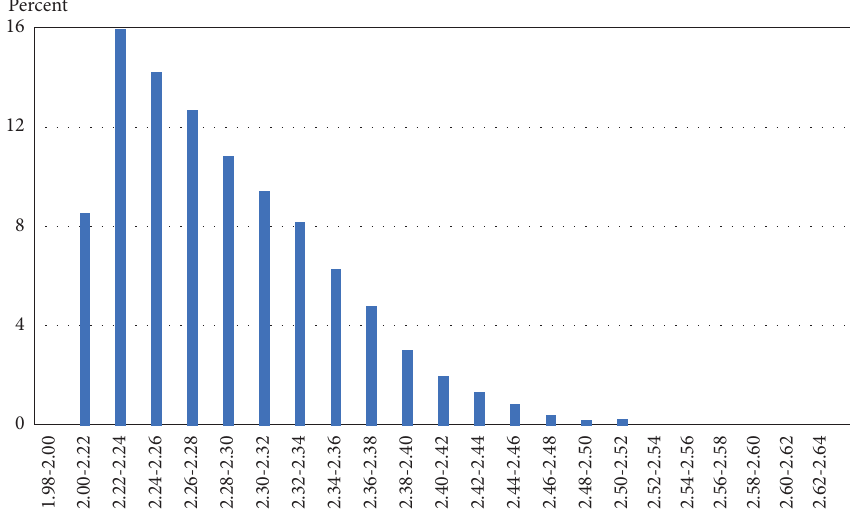
Figure 2: Loss of investment and construction efciency caused by agency